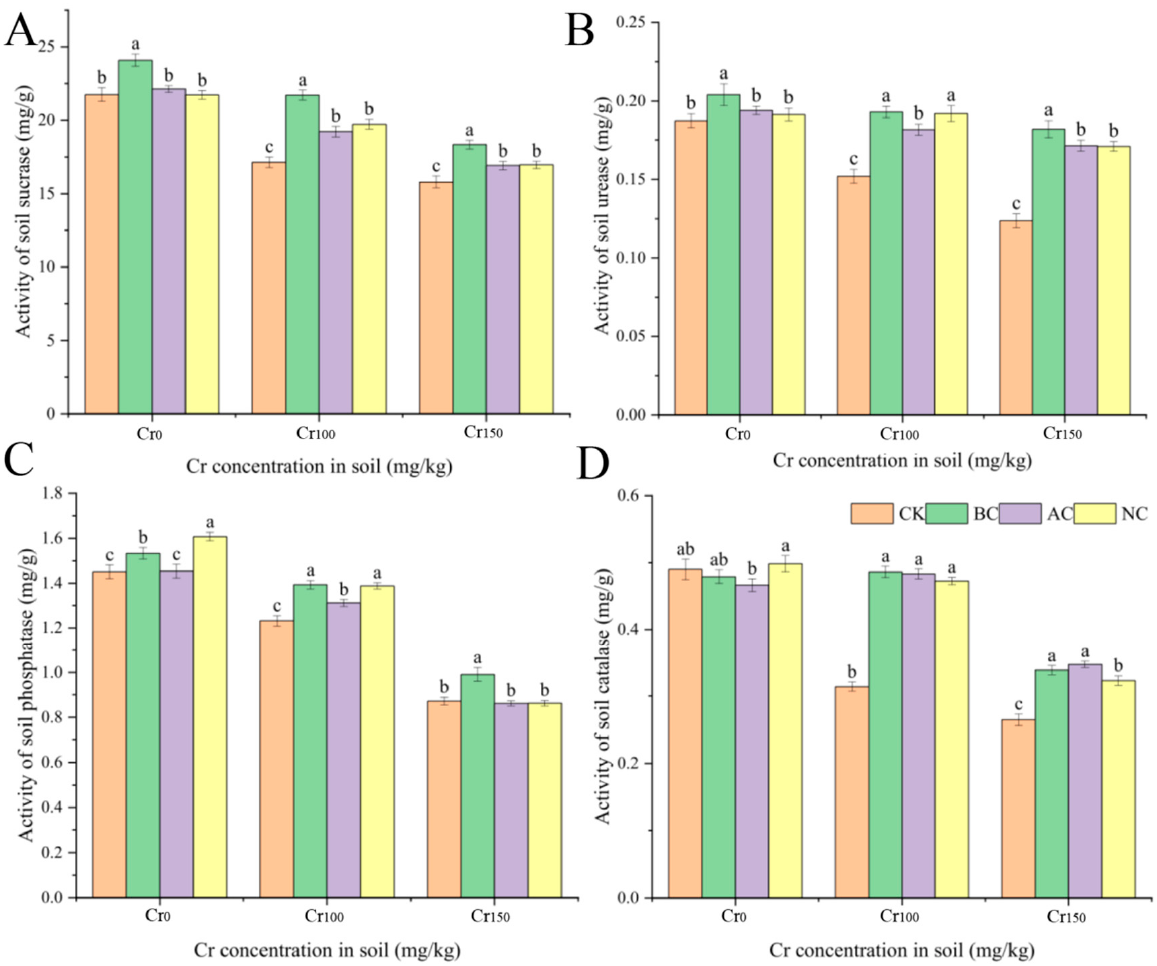
Figure 1. The effect of BC, AC, and NC application on soil enzyme activity under Cr stress. ( A ). The activity of soil sucrase. ( B ). The activity of soil urease. ( C ). The activity of soil phosphatase. ( D ). The activity of soil catalase. Data represent the means of three replicates ± SEs, and different letters indicate significant differences ( p < 0.05). Table 2. Effect of BC, AC, and NC application on the speciation of Cr in